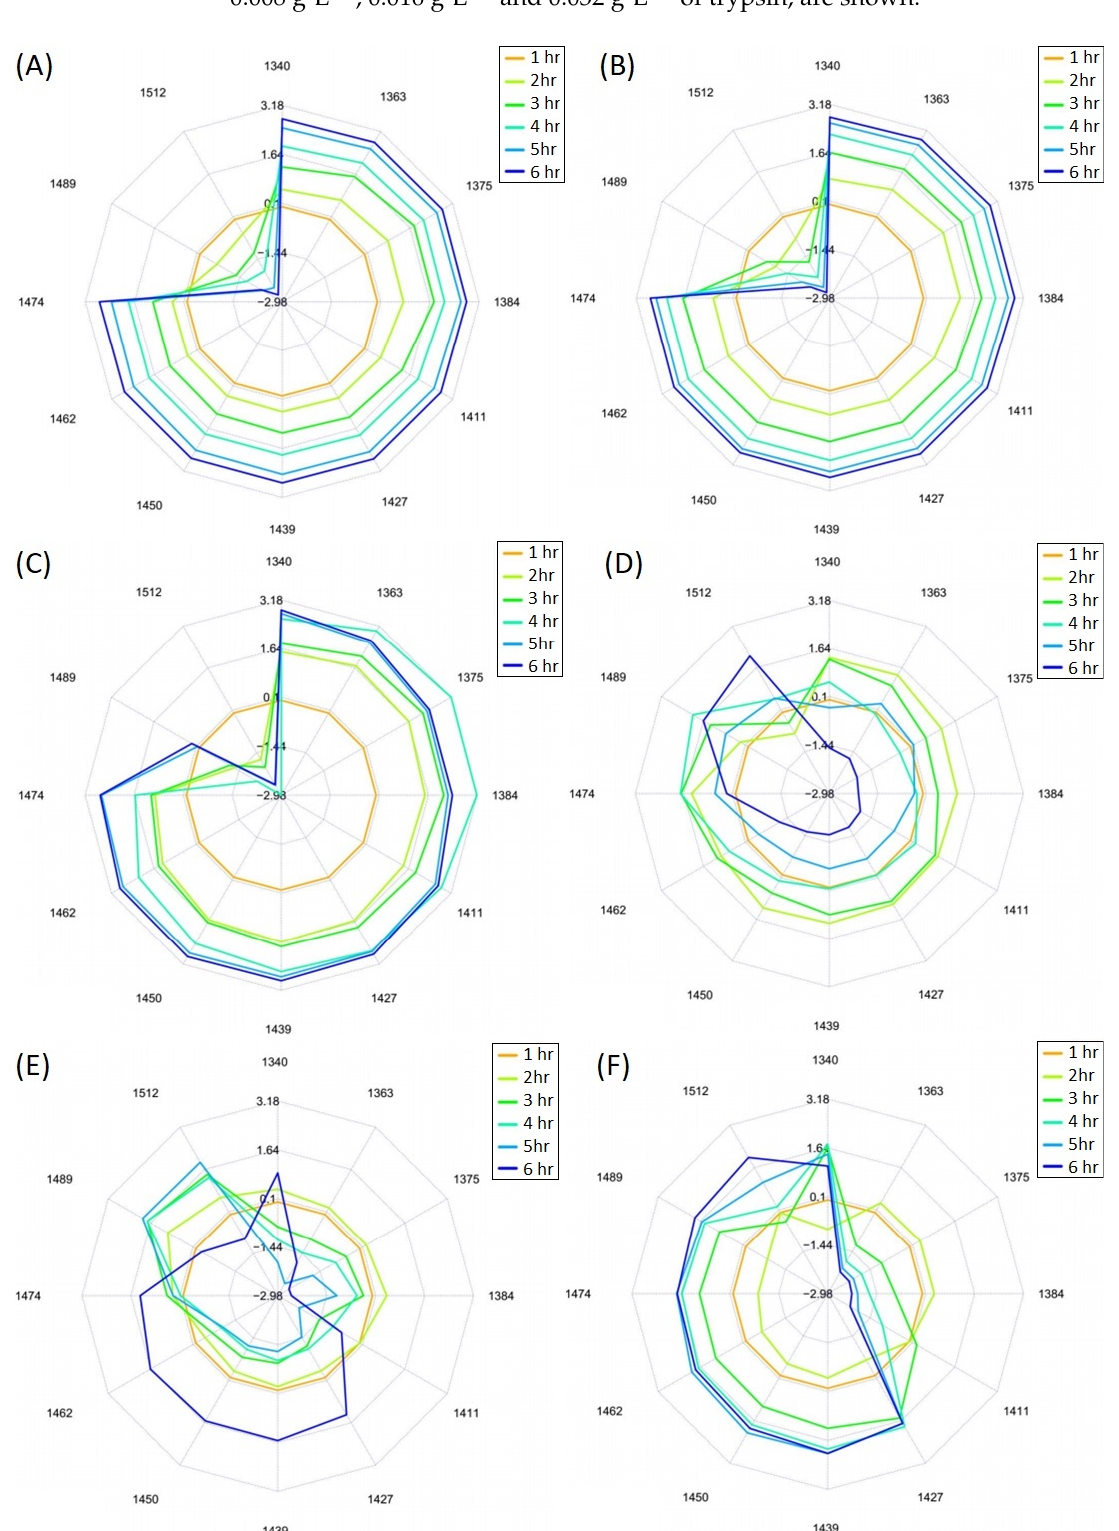
Figure 6. Aquagrams of the microbial hydrolysis of ( A ) LMPC-T-0.008, ( B ) LMPC-T-0.008 with glucose, ( C ) LMPC-T-0.016, ( D ) LMPC-T-0.016 with glucose, ( E ) LMPC-T-0.032, and ( F ) LMPC-T-0.032 with glucose.